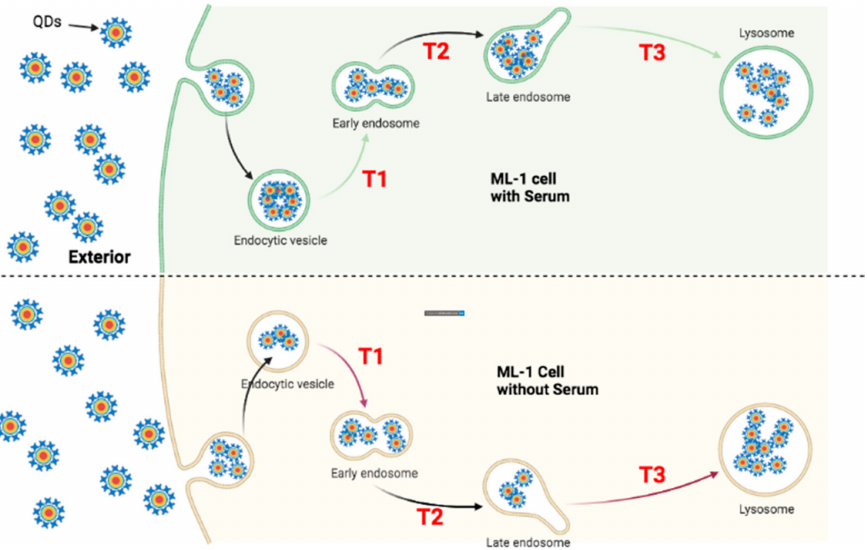
Figure 16. Proposed transportation kinetics of QDs in ML-1 cells grown in media with and without serum for 48 h. A figure illustrating intracellular trafficking kinetics of QDs varies in ML-1 cells grown with serum ( Upper ) and ML-1 cells grown without serum ( Bottom ) cells 48 h after the treatment of QDs. (T1) indicates the transition of QDs from the endocytic vesicle towards the early endosome; (T2) indicates the transition of QDs from the early endosome towards the late endosome; (T3) indicates the transition of QDs from the late endosome to the lysosome. Each green arrow represents a slower transit rate of QDs in comparison with its counterpart rate indicated in red. Each red arrow represents a faster transit rate of QDs in comparison with its counterpart rate indicated in